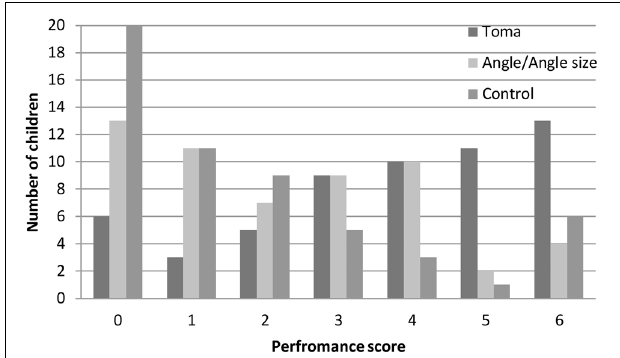
FIGURE 4 | Distribution of children’s post-test scores on the length-inconsistent task by